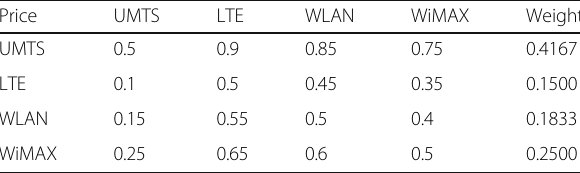
Table 15 Fuzzy consistent matrix and weights for